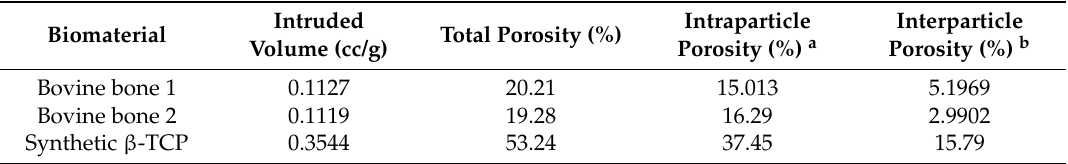
Figure 2. SEM micrographs of the different grafting materials: ( A ) synthetic TCP used as the control material; ( B ) bovine bone 1 (sintered material); and ( C ) bovine bone 2 (material not sintered). Table 1. Mercury-intruded volume, mode (most frequent diameter) of intraparticle pores, total porosity, and intraparticle porosity of the commercial samples.